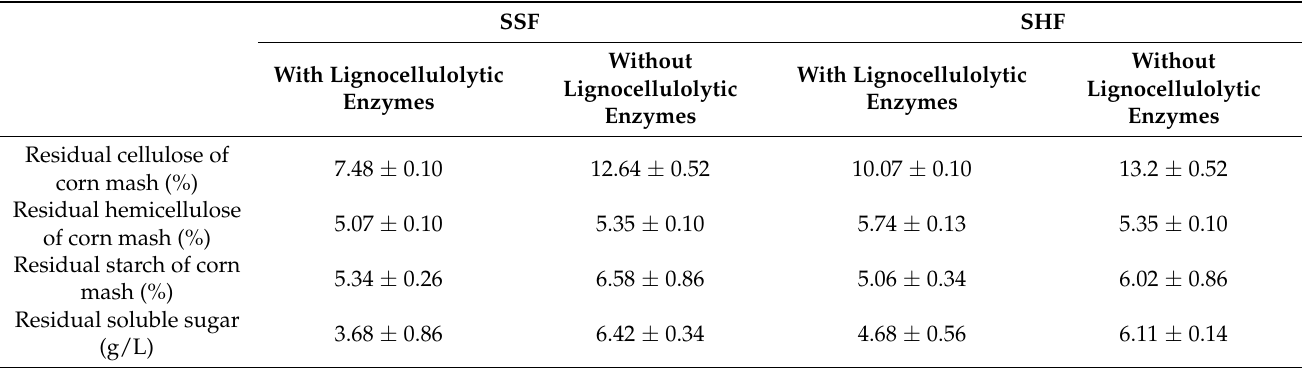
Table 3. The composition analysis of unutilized corn mash after SSF and SHF with/without lignocel- lulolytic enzymes